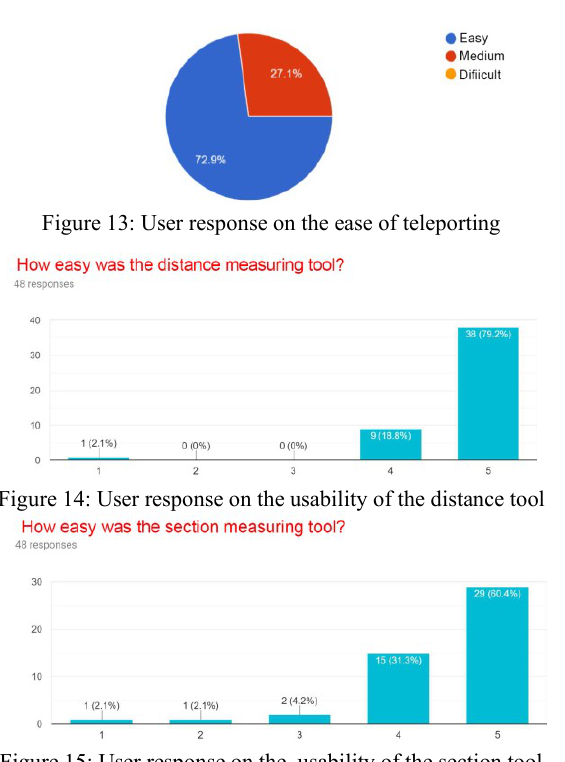
Figure 15: User response on the usability of the section